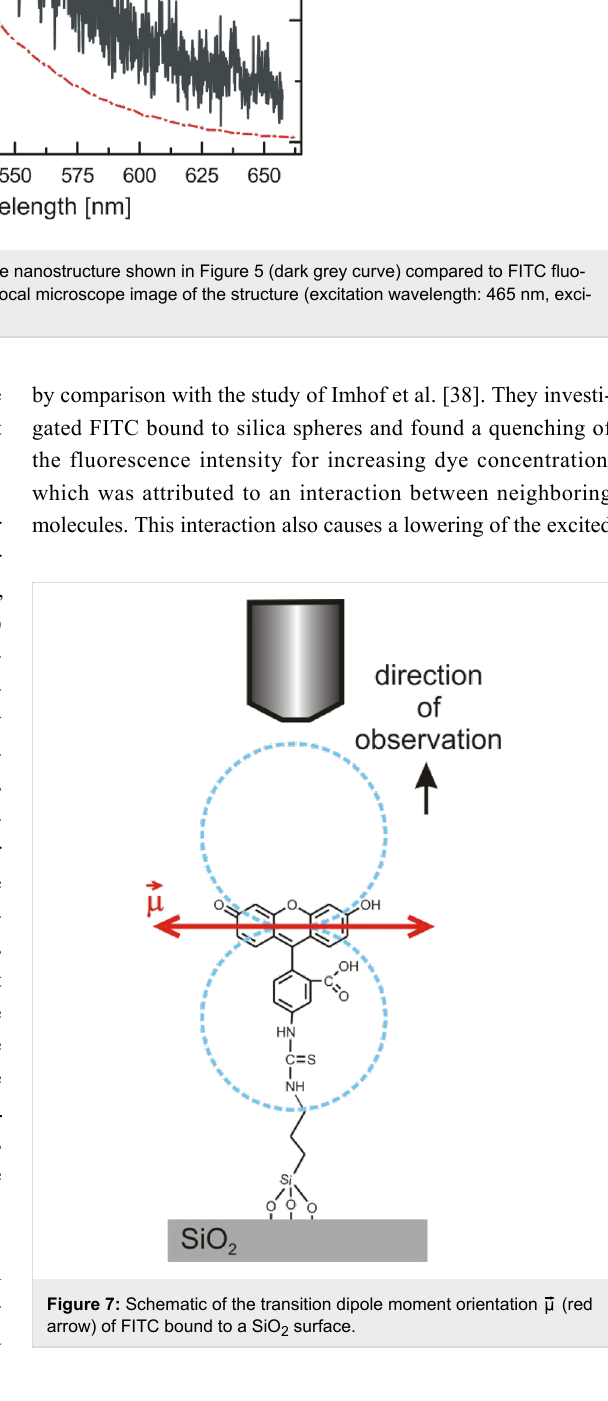
Figure 7: Schematic of the transition dipole moment orientation (red arrow) of FITC bound to a SiO 2 surface.